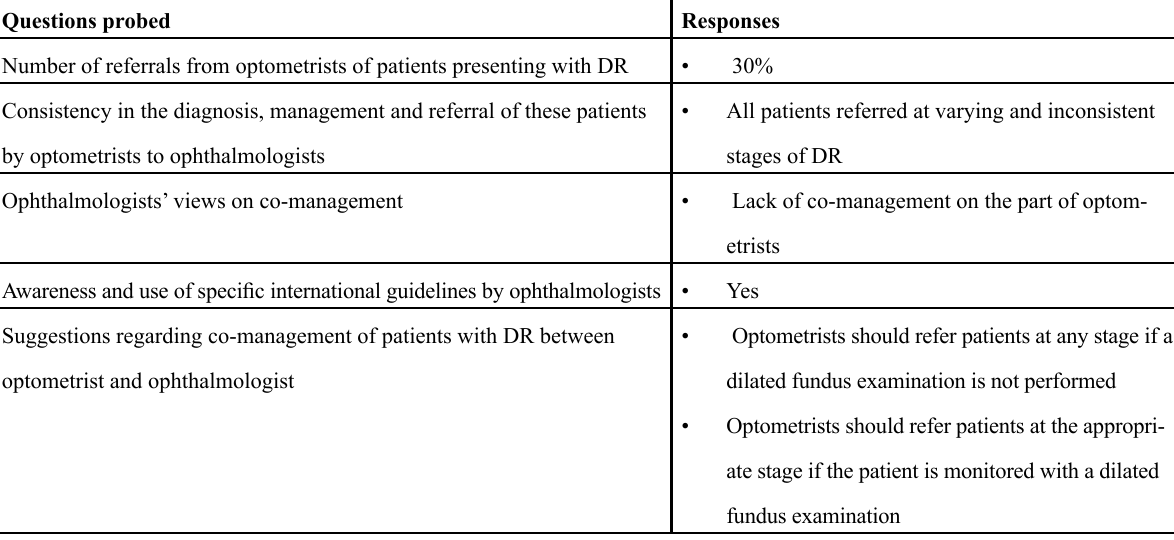
Table 4 : Thematic Analysis of Interviews with the Ophthalmologists Questions